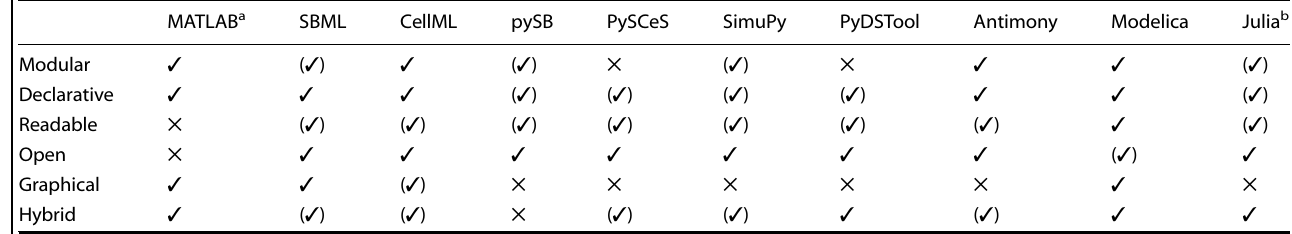
Table 1. Evaluation of language candidates with respect to the desirable MoDROGH characteristics established in this